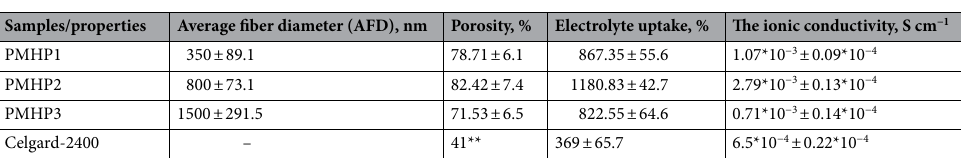
Table 2. Properties of crosslinked PMHP membrane as a function of ML content and Celgard separator. *All measurements were done at room temperature. ** From manufacturer’s specification.